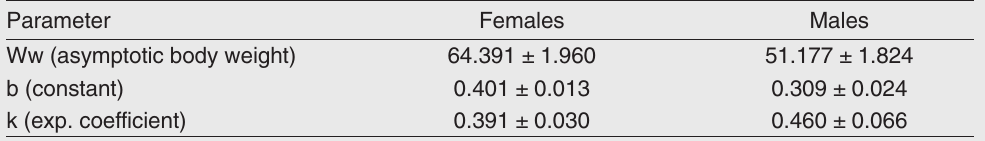
Table 3. Growth parameters (± S.E.) fitted to weight (kg) at age (years) data in West Greenlandic harbour porpoises, using the Gompertz model [Wt = Ww exp(- b exp(- k